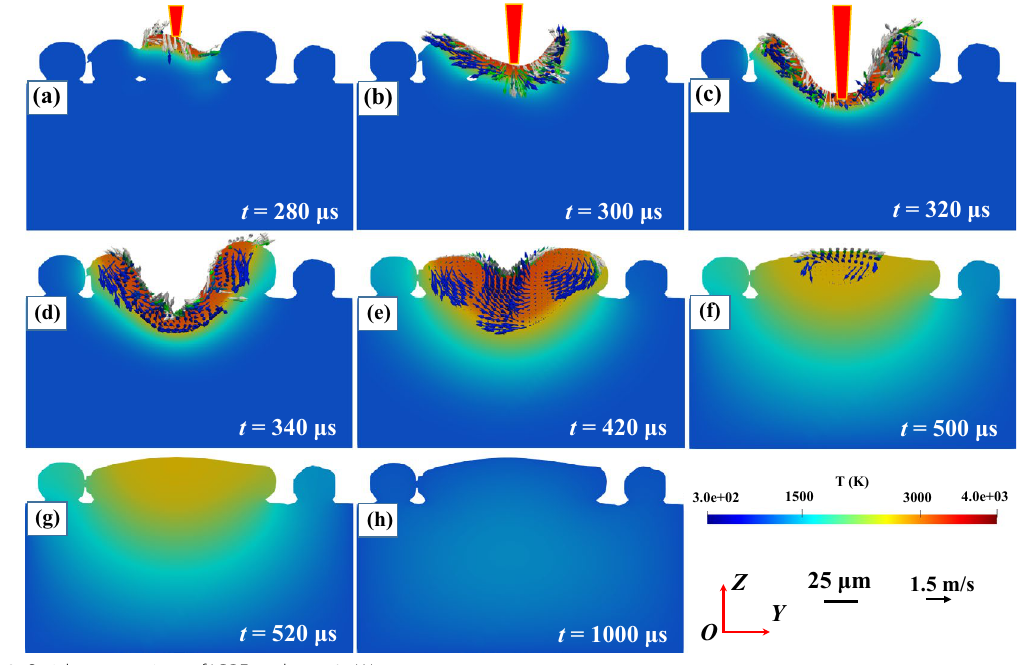
Figure 12 Serial cross-sections of LPBF tracks at 195 W